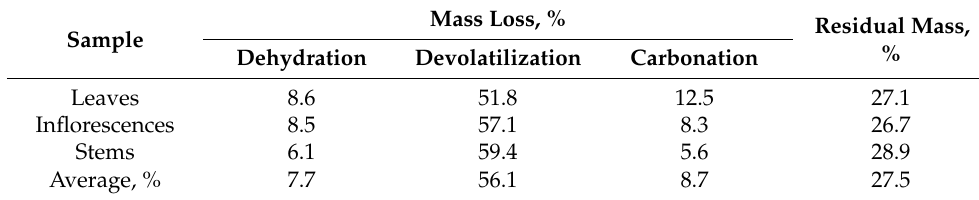
Table 3. TG-data on changes in mass.